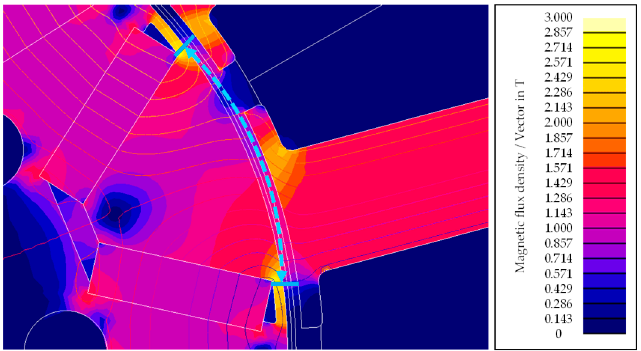
Figure 2. Flux density and flux lines over one pole of magnet at no load from finite element analysis (FEA).